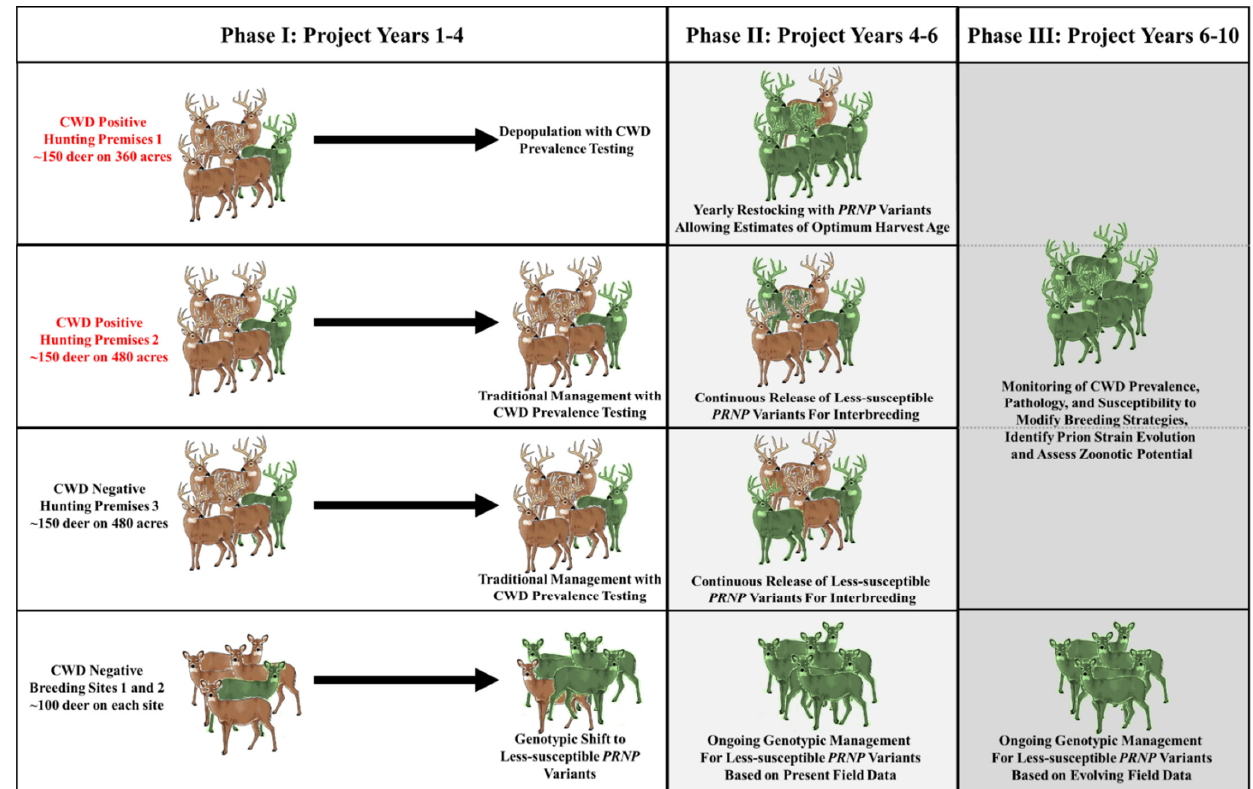
Figure 1. Project overview . This schematic highlights phase I strategies for hunting premises 1, 2, and 3, initially planning for a “clean slate” approach on premises 1—a gradual depopulation followed by systematic introduction of animals with various genotypes, including those with resistant genotypes (shaded green). On hunting premises 2 and 3, a more gradual introduction of animals with resistant genotypes was initially planned, with genotypic shifts expected in situ as these animals bred with animals of more susceptible genotypes. This plan on premises 2 and 3 was later modified to be more in line with the clean slate strategy for premises 1, based on rising prevalence rates on site 2. On both breeding sites, selective breeding and genotypic shifts would be balanced with desirable phenotypic traits, eventually leading to complete removal of 96G PRNP variants (e.g., those animals without nonsynonymous SNPs at other positions) in favor of 95H, 96S, and 226K variants. These animals would be used to stock each of the hunting premises. In phases II and III, data on prevalence, pathology, transmission, and strain evolution will be used to modify selective breeding strategies as necessary. CWD, chronic wasting disease.